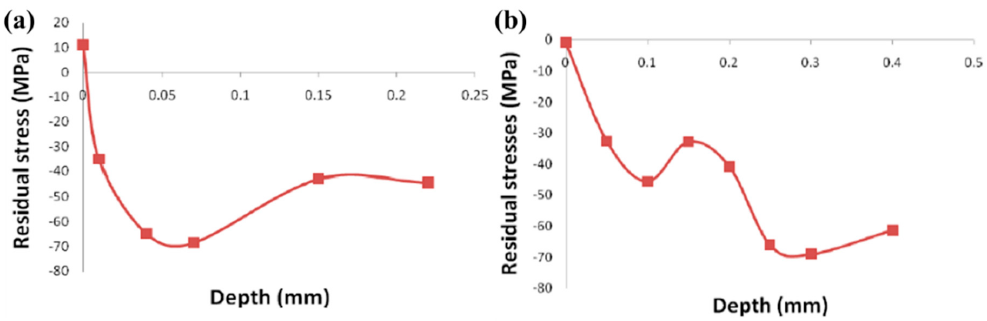
Figure 14. In-plane stress distributions in the cold sprayed Al coating ( a ) before and ( b ) after shot peening [71].